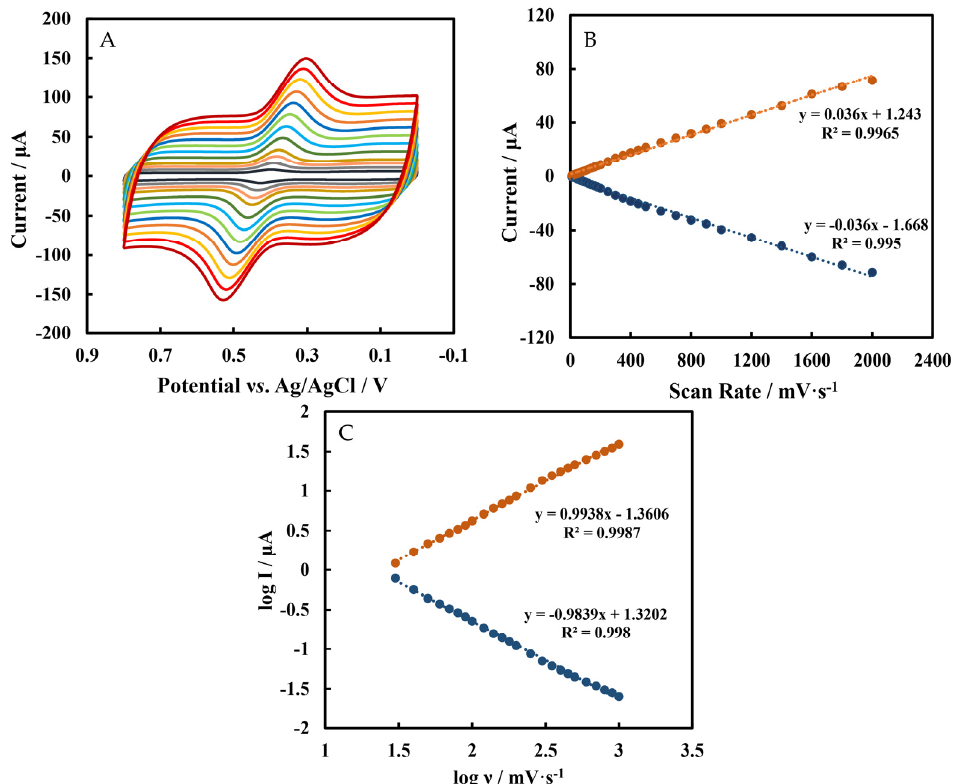
Figure 5. ( A ) CVs of Chi/HFs-Lac/MWCNTs-CTAB/GCE in pH 4 50 mmol L − 1 phosphate − buffered solution containing 5 µ mol L − 1 rutin at scan rates (from inner to outer) of: 0.1, 0.2, 0.3, . . . , 1.4, 1.6, 1.8, 2 V s − 1 ( B ) The relationship between scan rates (0.01 V s − 1 –2 V s − 1 ) and peak currents. ( C ) The rela- tionship between log ν and log I.